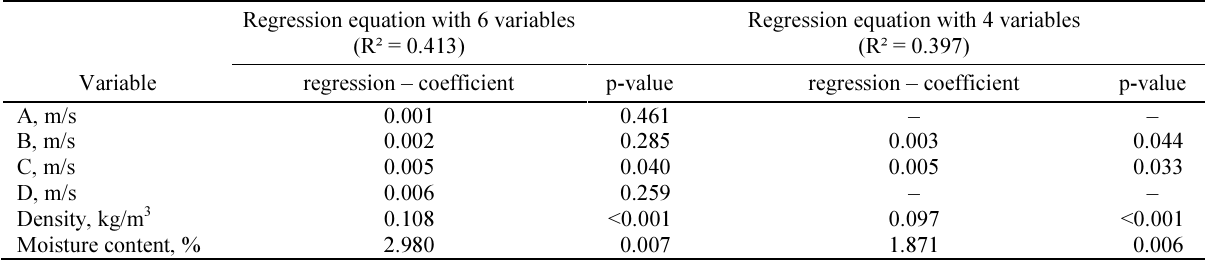
Table 6. Predicting bending strength (y) with multiple variables (x) Regression equation with 6 variables Regression equation with 4 variables (R² = 0.413) (R² = 0.397) Variable regression – coefficient p-value regression – coefficient p-value A, m/s 0.001 0.461 – – B, m/s 0.002 0.285 0.003 0.044 0.005 0.040 0.005 0.033 0.259 – – 0.108 <0.001 <0.001 Moisture content, % 0.006 80% and 40%, respectively. The other methods of meas- uring ultrasound velocity over smaller measuring distanc- es gives only so-called local results of specimens, there- fore they do not give assessment on a larger scale and they are not statistically significant. Thus the larger the measuring distance, the better the dependent variable can be